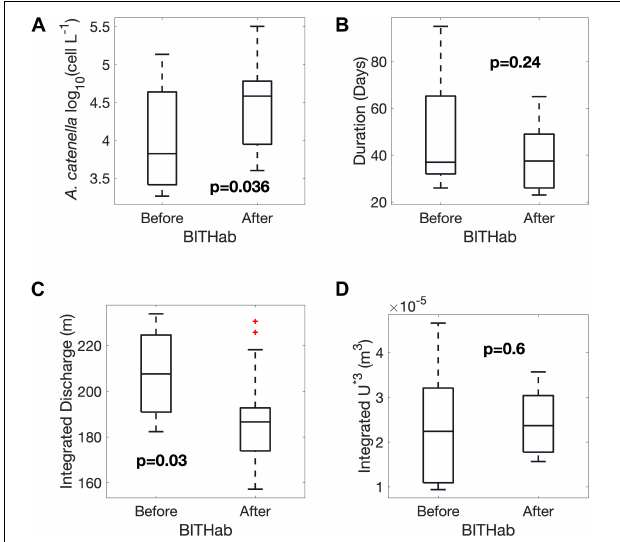
FIGURE 6 | Differences between years in which blooms occur before or after the mean BITHab date as boxplots showing the mean, standard deviation and total range of the Magnitude (A) and Duration (B) of A. catenella blooms, spring St. John River Freshwater Discharge (C) and spring Wind-Driven Turbulent Momentum (D) ( C and D are integrated in time from March through May).